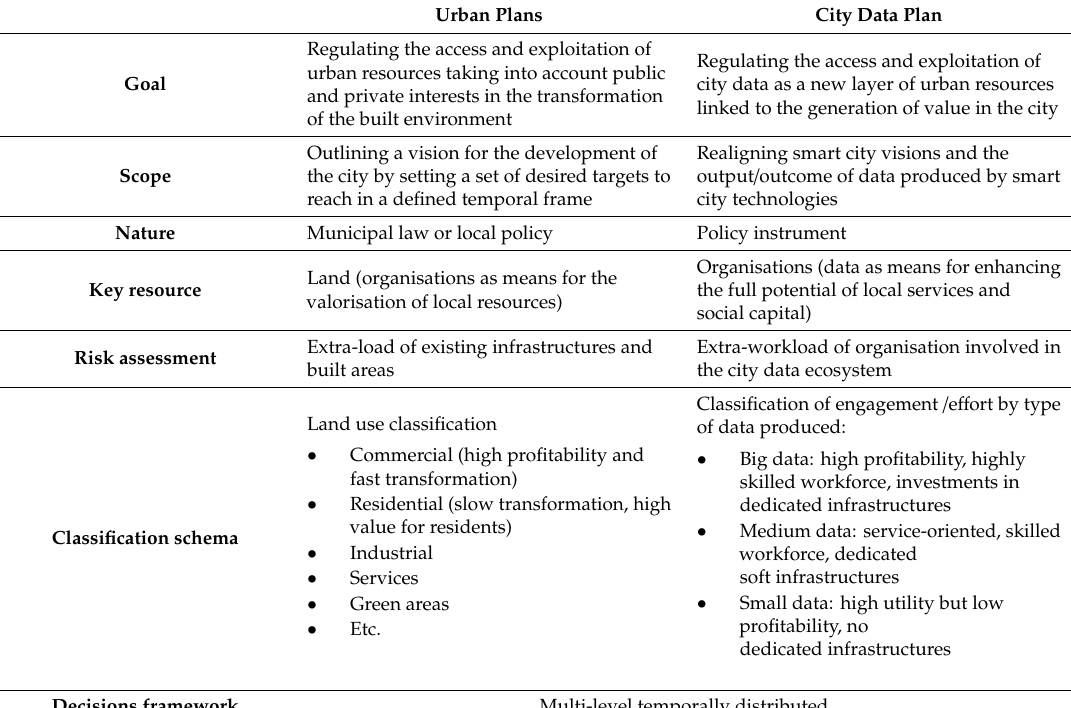
Table 2. Overview of the key aspects of urban plans informing the conceptualisation of the City Data Plan (source: author’s